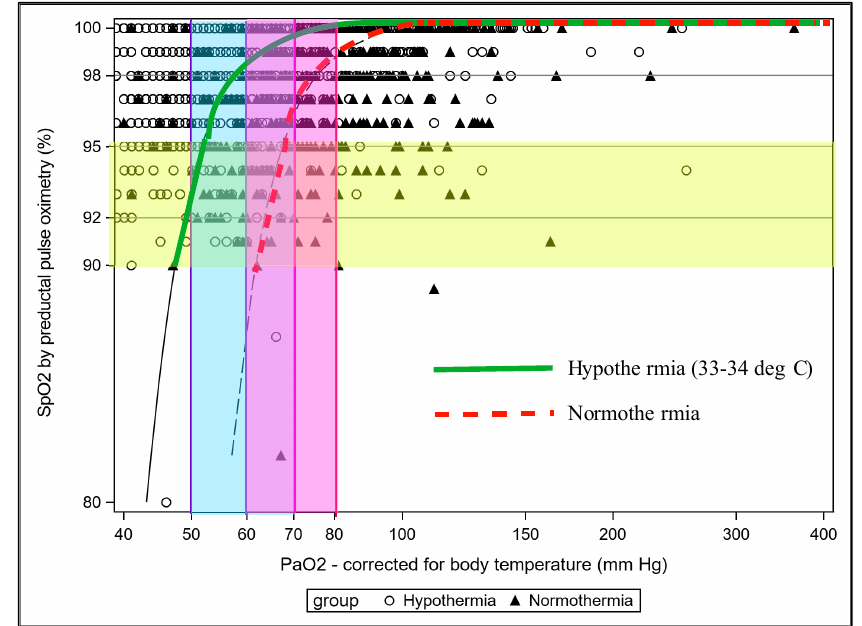
Figure 5. The relation between SpO 2 ( y -axis) and PaO 2 ( x -axis) in hypothermia and normothermia is shown. In normothermia and hypothermia, the relationship between SpO 2 and PaO 2 is altered. Targeting a preductal corrected PaO 2 of 50–80 mmHg may require preductal SpO 2 in the mid- to high 90 s during management of severe PPHN on whole body hypothermia. Copyright Satyan